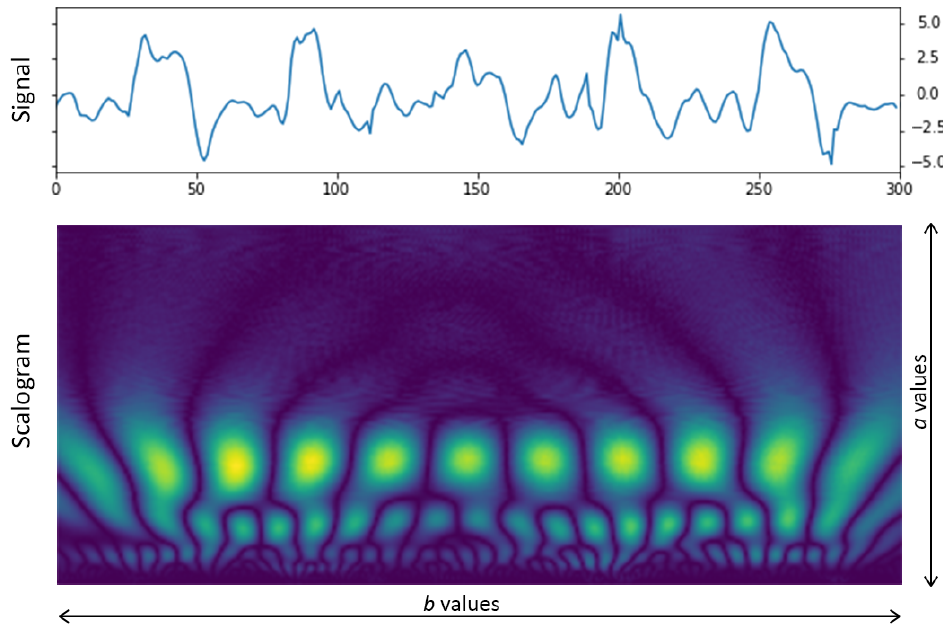
Figure 2. An example of a transformed accelerometer